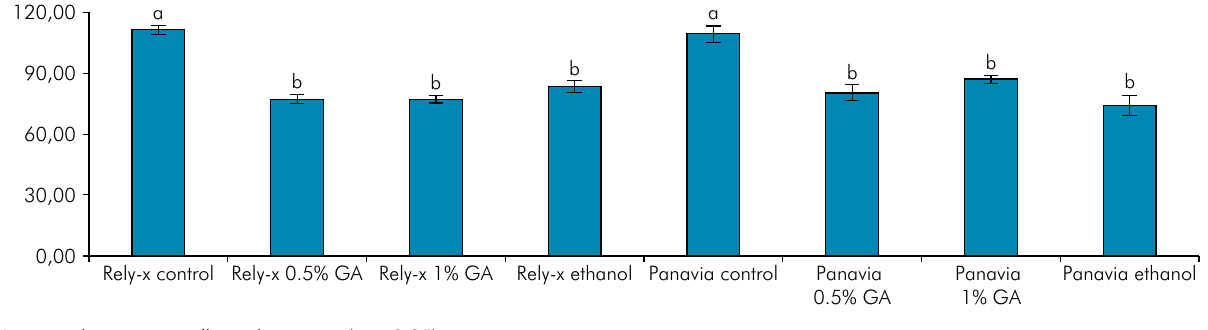
Figure 2. Biaxial flexure strength (MPa).